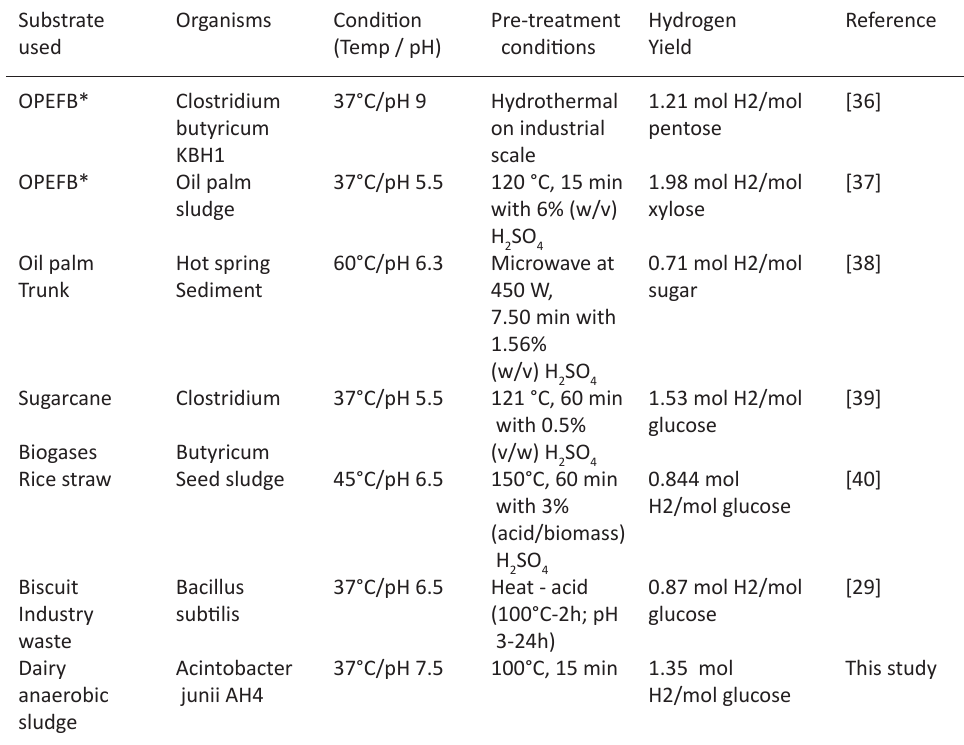
Table 4. Comparison of fermentative hydrogen production Substrate